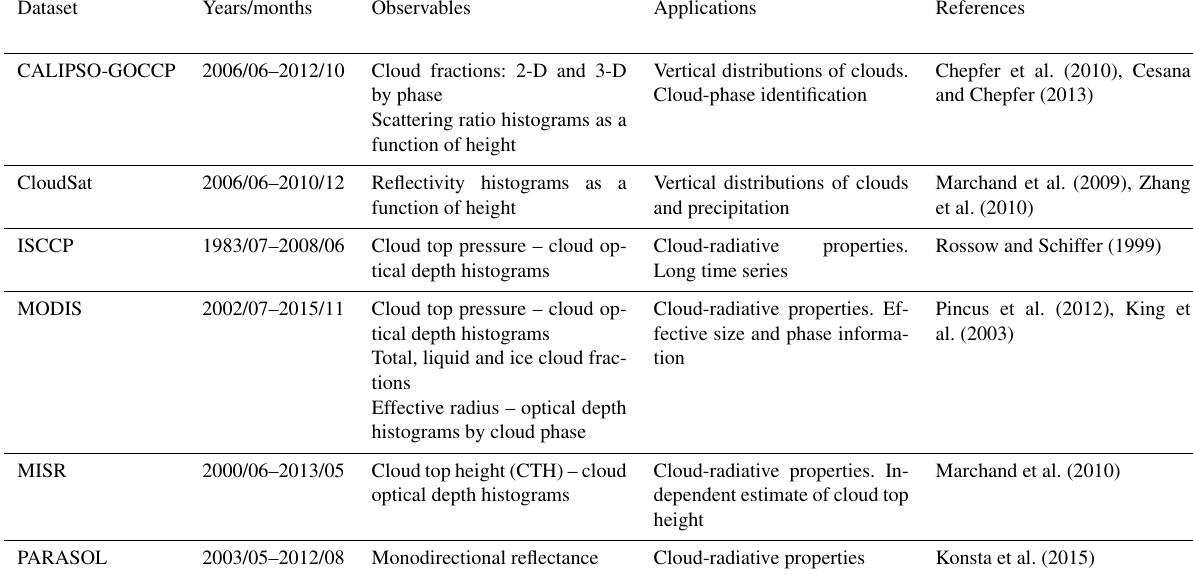
Table 3. Summary of CFMIP-OBS observational datasets available for comparison with COSP